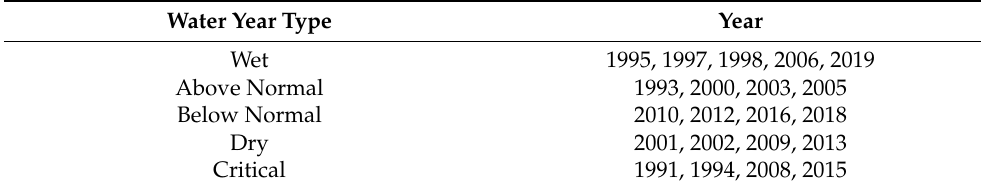
Table A10. Years of data manually selected for